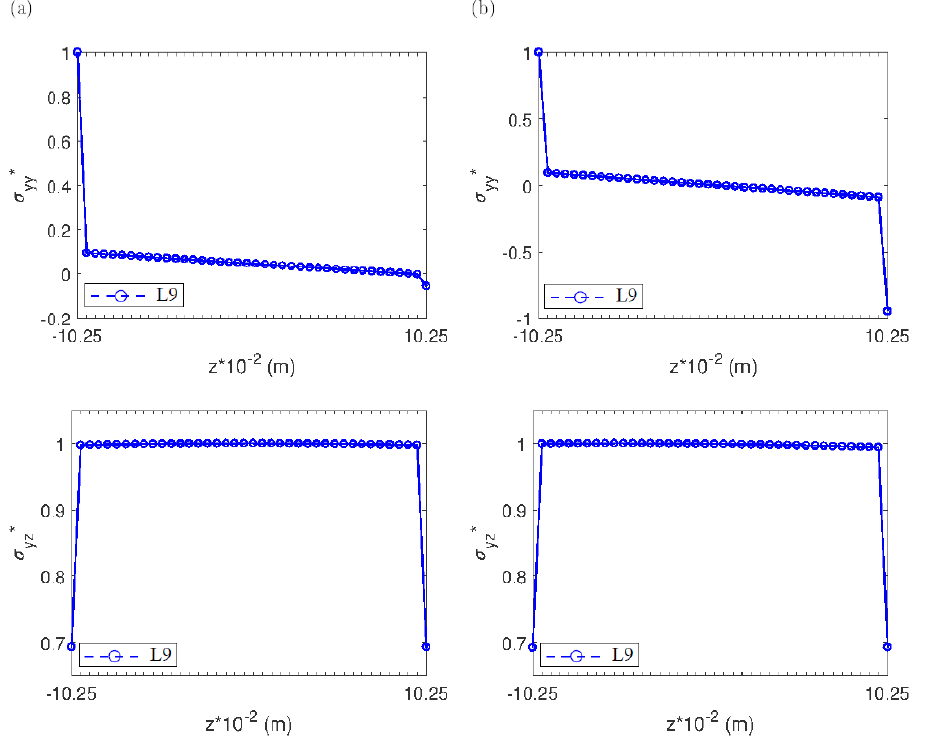
Figure 18. Distribution of axial and shear stress components for ( a ) P ∗ = − 0.0086 and ( b ) P ∗ = − 0.162 loads in NL regime at L4 and L9 extensions at x = − a 2 /2 and y = L /2 in the two- cell composite beam subject to axial loading; σ ∗ yy = σ yy / σ yy